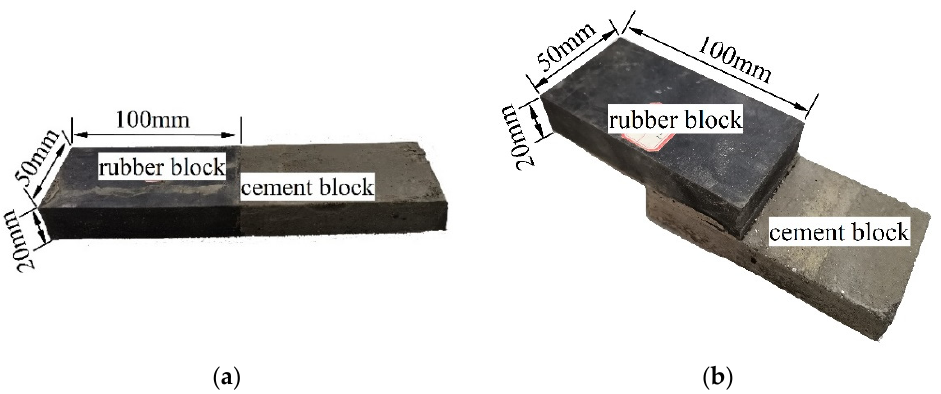
Figure 5. Waterproofing mechanism of the waterstop. ( a ) Tensile specimen. ( b ) Shear specimen. A tension machine (0–1000 N) was used as test equipment (Figure 6). Since the specimen was rectangular, the bonding force between rubber and concrete was small, and the bonding interface brittle. So, the selected tensile speed was 0.1 mm/min. The tensile or shear strength is the maximum stress that the test piece bears in the process of bond failure caused by an external force. The average strength of the three specimens in each group was taken as the test result (Table